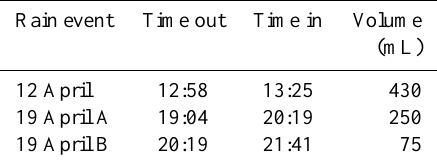
Table 2. Summary of rainwater collection